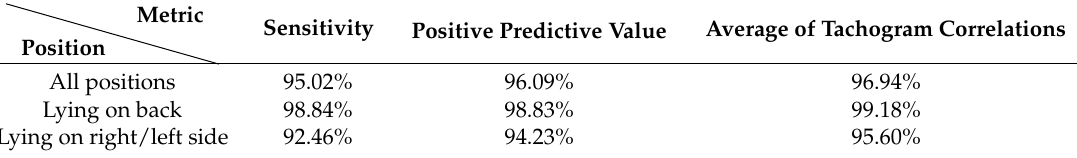
Table 4. Summary of beat detection and heart rate statistics of non-contact ECG measurements compared with the reference when including the best channel from each measurement.